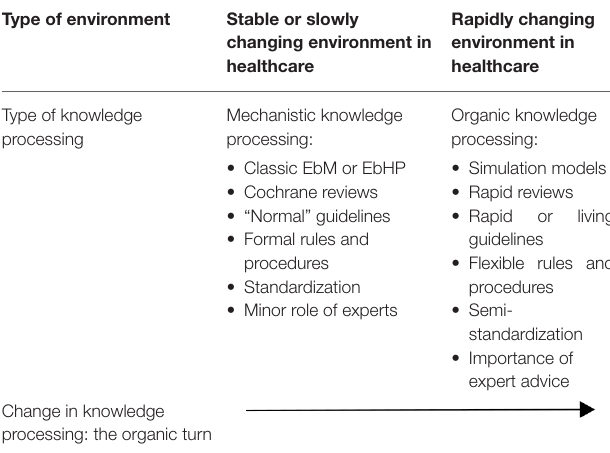
TABLE 2 | The organic turn: moving from mechanistic to organic knowledge